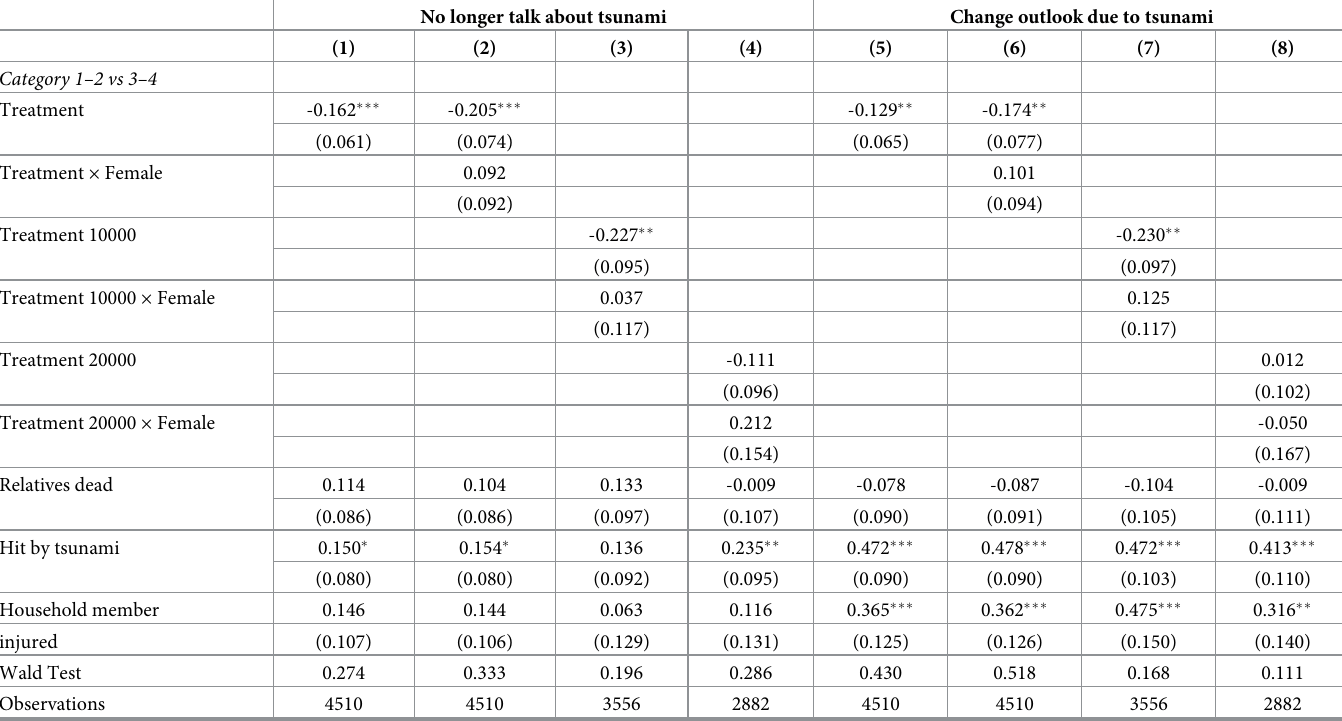
Table 10. Impacts of treatment on psychological